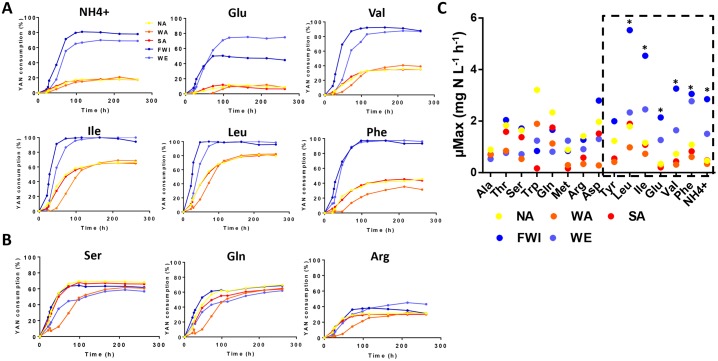
Comparison of the N source consumption dynamics between the strains.(A) Comparison of the consumption kinetics of the N sources differentially consumed between the strains. (B) Comparison of the N sources consumed at equal rates by all five strains. The YAN consumption is expressed as a percentage based on the amount of nitrogen consumed by yeast at the end of the fermentation. (C) Comparison of the maximum uptake rates (μMax values) (mg N L-1.h-1) of the N sources between the strains. Data within the dashed box correspond to the N sources with the best consumption profiles for the WE and FWI strains. Mean values were calculated from three replicates from each strain. Values marked with an asterisk are significantly different (pIle<0.050; pGlu<0.023; pVal<0.050; pPhe<0.002; and pNH4+<0.040).